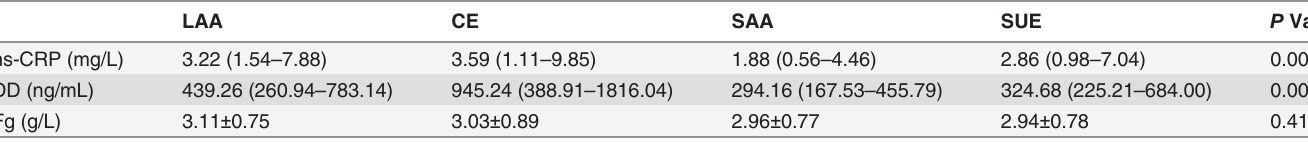
Table 2. Distribution of three biochemical markers in various